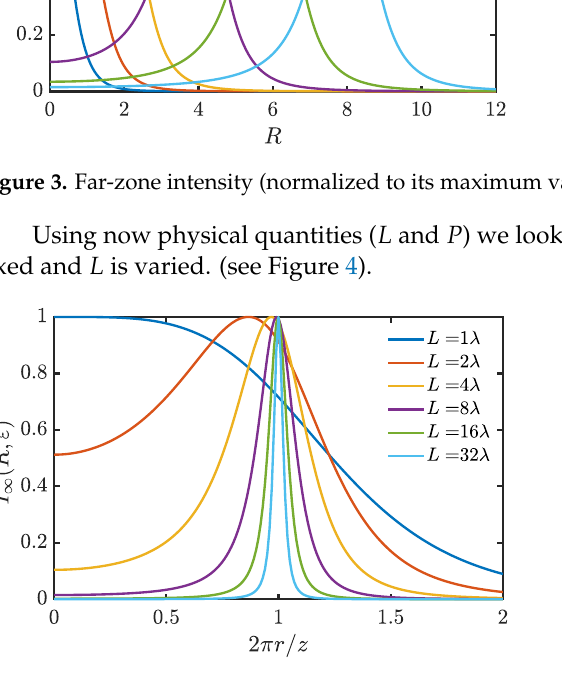
Figure 4. Far-zone intensity (normalized to its maximum value) for P / λ = 2 π and several values of L